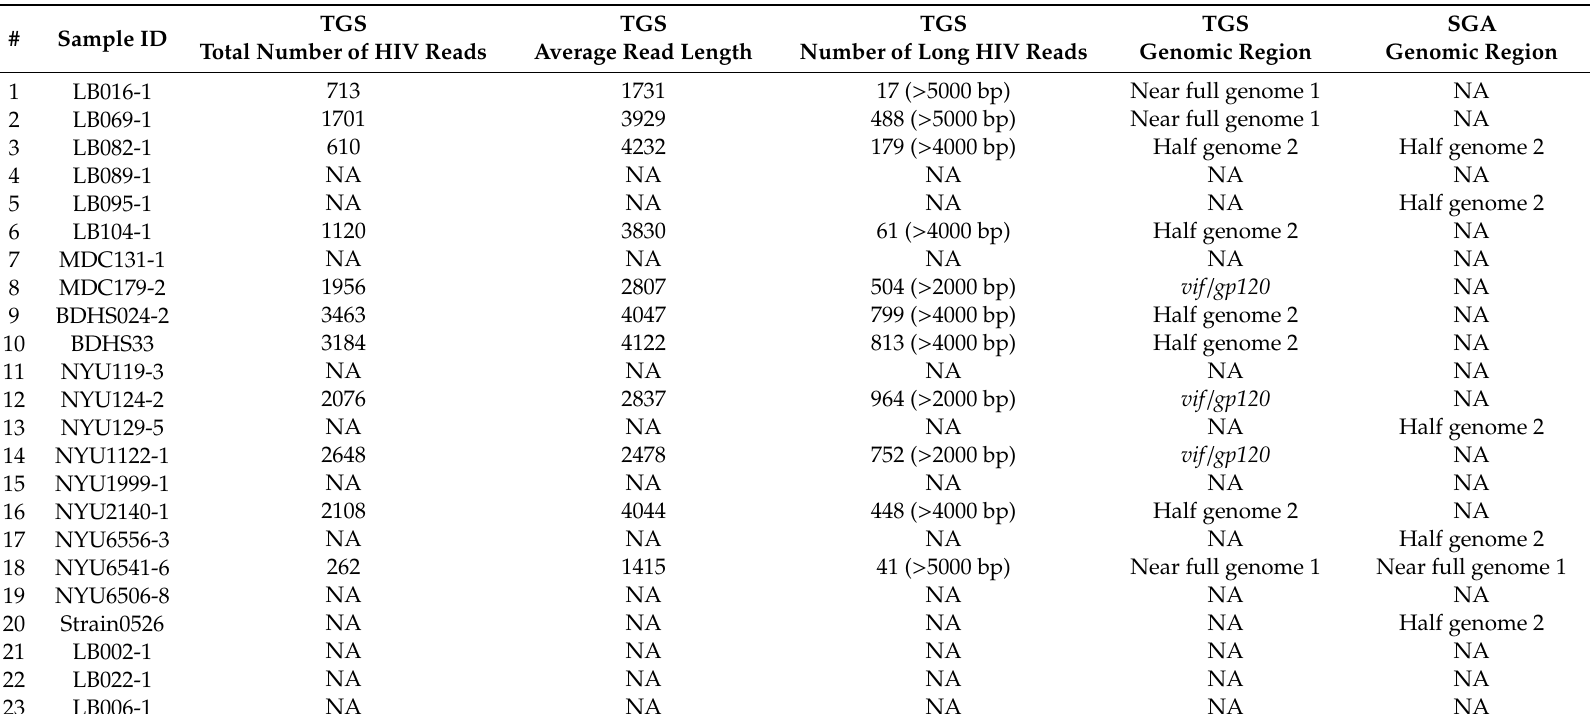
Table 5. Summary of third-generation sequencing (TGS) and single-genome amplification